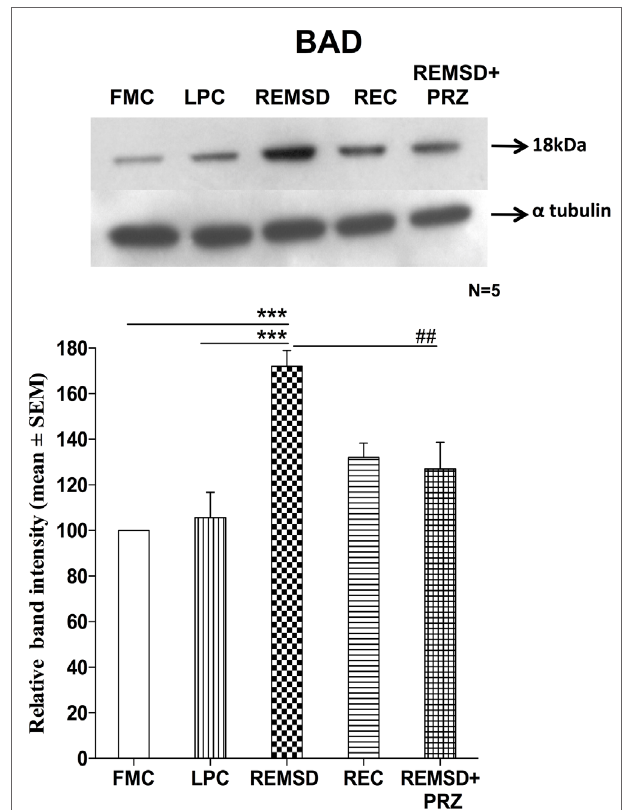
FigUre 2 | BaD expression in the brain homogenate of rats under different conditions . Upper panel shows a representative Western blot of BAD expressions in the brain of rats exposed to various control and experimental (REMSD) conditions. Histogram in the lower panel shows percent changes in the mean ( ± SEM) band densities of the blots as compared to FMC taken as 100% in five sets of experiments. Abbreviations are as in the text. Significance levels are between the treatments of connecting horizontal bars; *** p < 0.001 and ### p < 0.001, * as compared to FMC and # as compared to